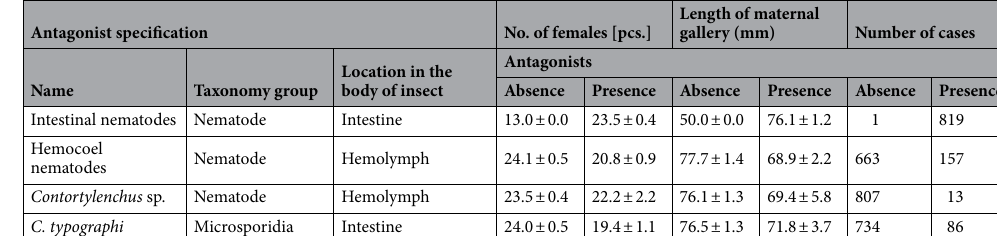
Length of maternal gallery (mm) Number of cases